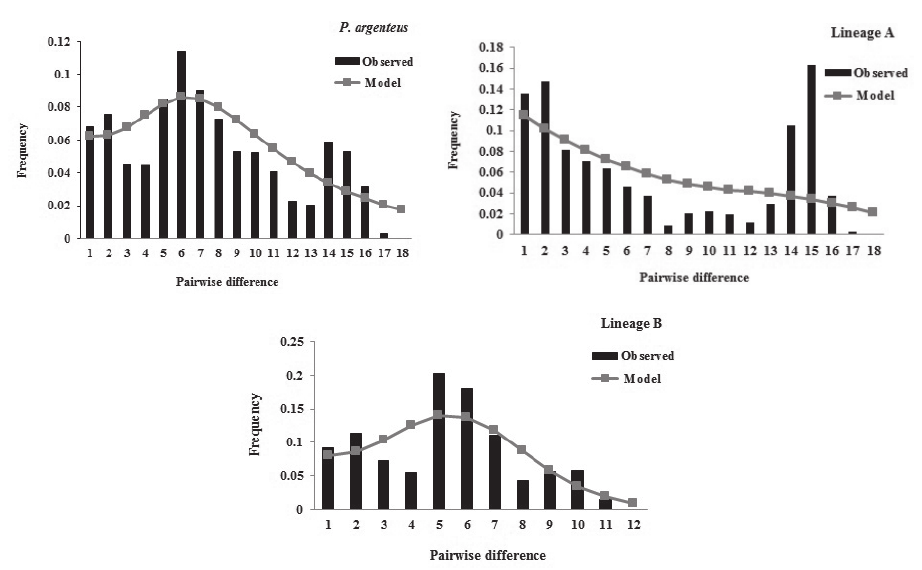
Figure 4. Mismatch distributions of control region haplotypes of P. argenteus.